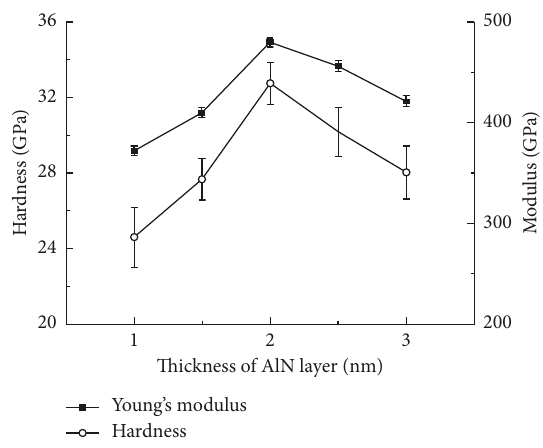
Figure 3: Hardness and Young’s modulus of TiSiN/AlN nano- multilayers with different thicknesses of AlN